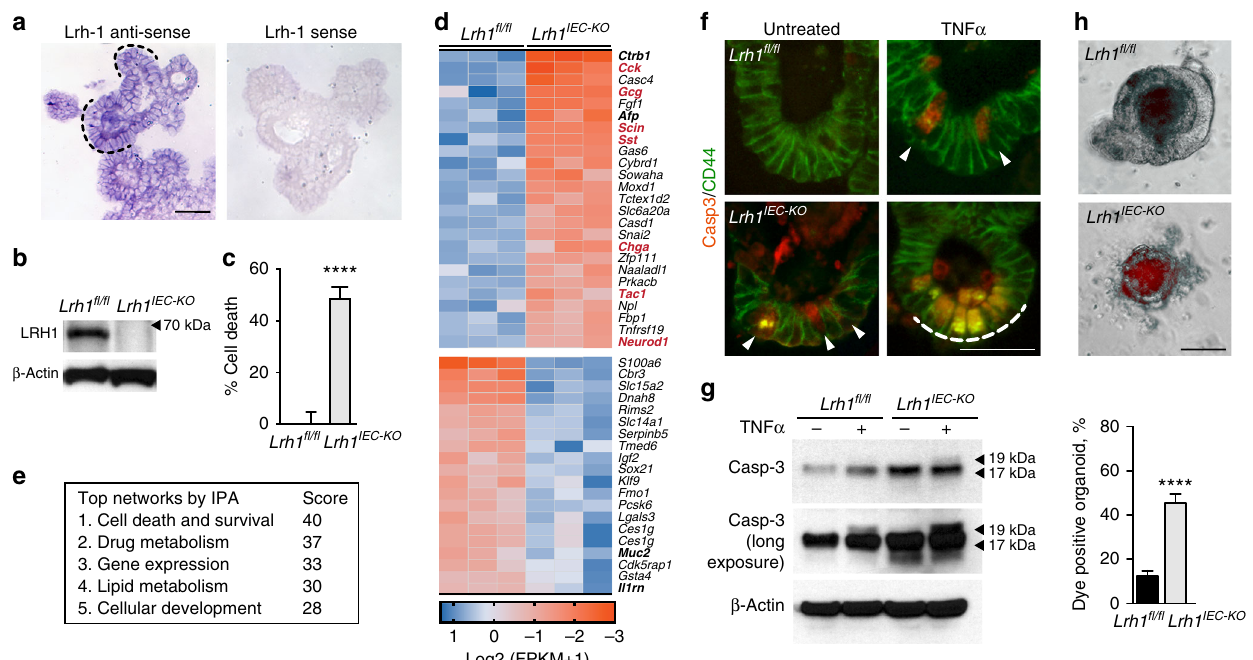
Fig. 1 Effects of loss of LRH-1 on murine organoids. a Expression of mLRH-1 transcripts in intestinal organoids is widespread and higher in crypt regions (dashed black line). Scale bar = 100 μ m. b Loss of mLRH-1 after Cre-recombination induced by 4-hydroxytamoxifen (4OHT) added to Lrh-1 fl / fl ;Vil-CreERT2 organoids for 48 h ( Lrh1 IEC-KO ) compared to similarly treated wild-type ( Lrh1 fl / fl ) organoids, as detected by anti-LRH-1 antibody. c Cell death in Lrh1 fl / fl and Lrh1 IEC-KO organoids following acute loss of Lrh-1 . Values normalized to fi ve independent wells of untreated Lrh1 fl / fl organoids taken to be 0%. d Most signi fi cant gene changes up (blue) or down (ochre) after loss of mLRH-1 by RNA expression ( q = < 0.05 and p = < 0.005). Gene names in bold refer to markers of differentiation while red refer to known EEC markers. e Top fi ve altered gene networks as identi fi ed by IPA Ingenuity analysis. f Lrh1 fl / fl and Lrh1 IEC-KO organoids exposed to TNF α (10 ng/ml) for 40 h stained for active Casp3 (red) and CD44 (green). Cells expressing active Casp3 undergoing cell death in crypt regions are indicated (white arrowheads and dashed white line). Scale bar = 50 μ m. g Expression of active Casp3 in Lrh1 fl / fl and Lrh1 IEC-KO organoids as described in panel f , detected by western blotting (17 and19 kDa, black arrowheads). Shorter (top panel) and longer exposures (middle panel). h Uptake of fl uorescent dextran after 30 min in Lrh1 fl / fl and Lrh1 IEC-KO organoids. Scale bar = 100 μ m. Bar graph of percentage dye-positive enteroids ( ≥ 30 total organoids counted per condition). Data represent average of minimum three biological triplicates. For c and g , error bars are SEM using Student ’ s t test (unpaired, two tailed) with p values of **** p = <